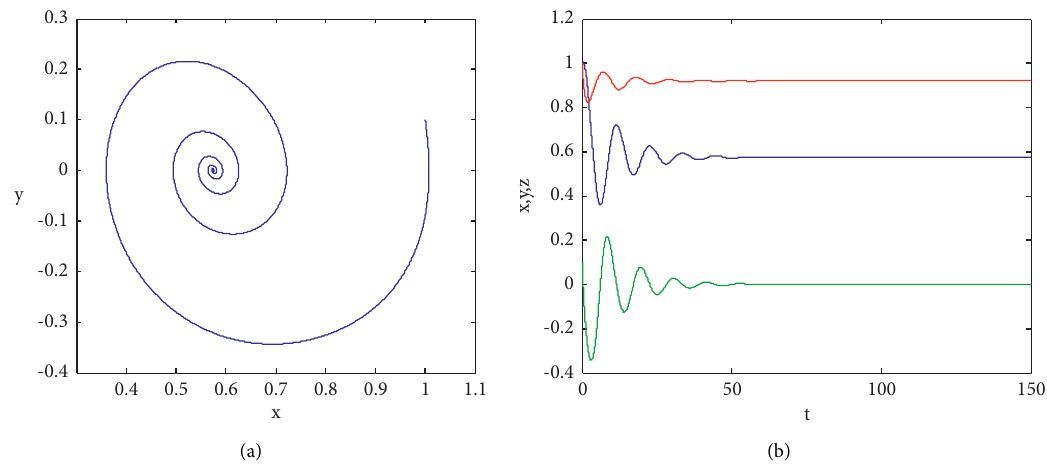
Figure 3: (a) Phase diagram of system (3). (b) The evolution of the state variables with